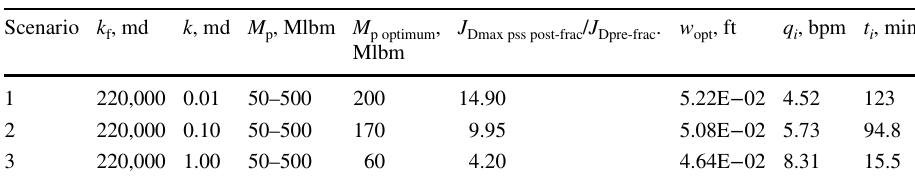
Scenario k f , md